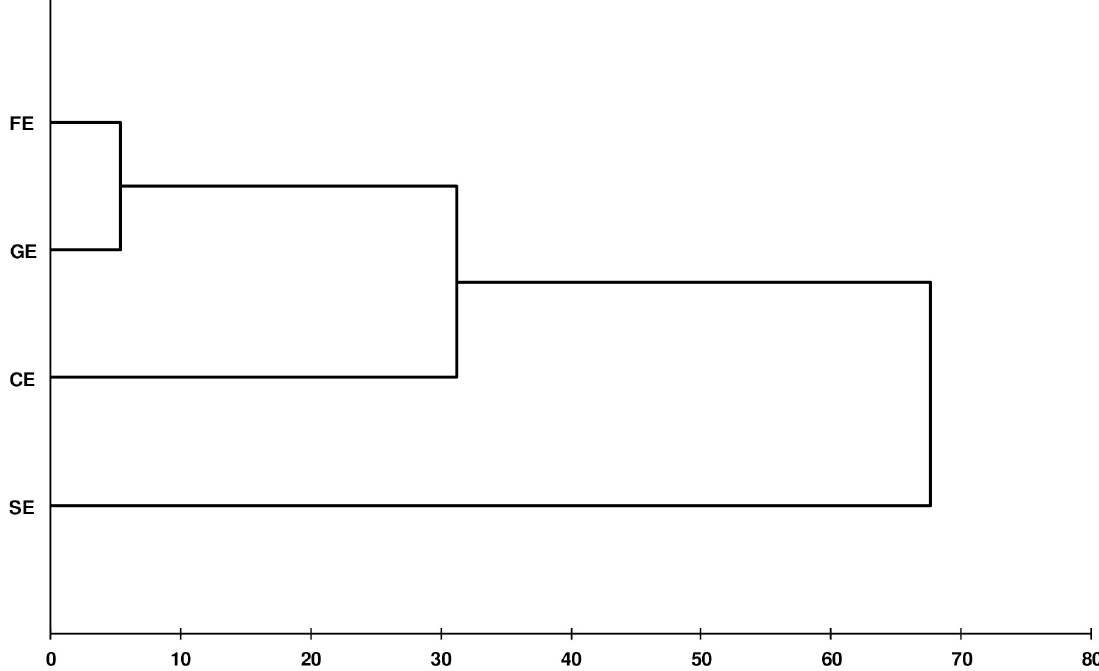
Fig 5. UPGMA similarity dendrogram. Euclidean distances showing clustering relationships of four ecotypes based on morphological characters.